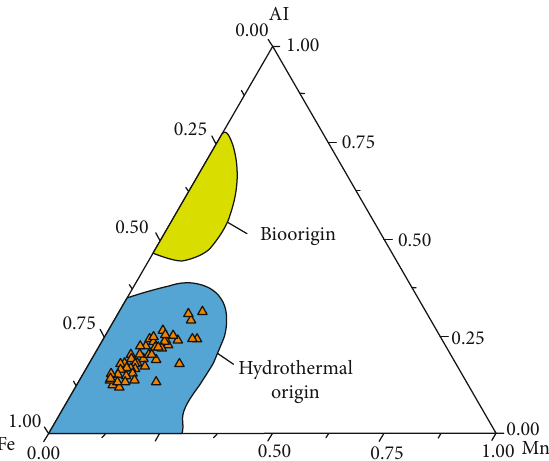
Figure 5: Through the Al-Fe-Mn ternary plot analysis, siliceous minerals from the Lower Cambrian Wangyinpu Formation in Well JXY1 contain excess siliceous minerals, which are derived from hydrothermal origins. See Figure 1 for the well